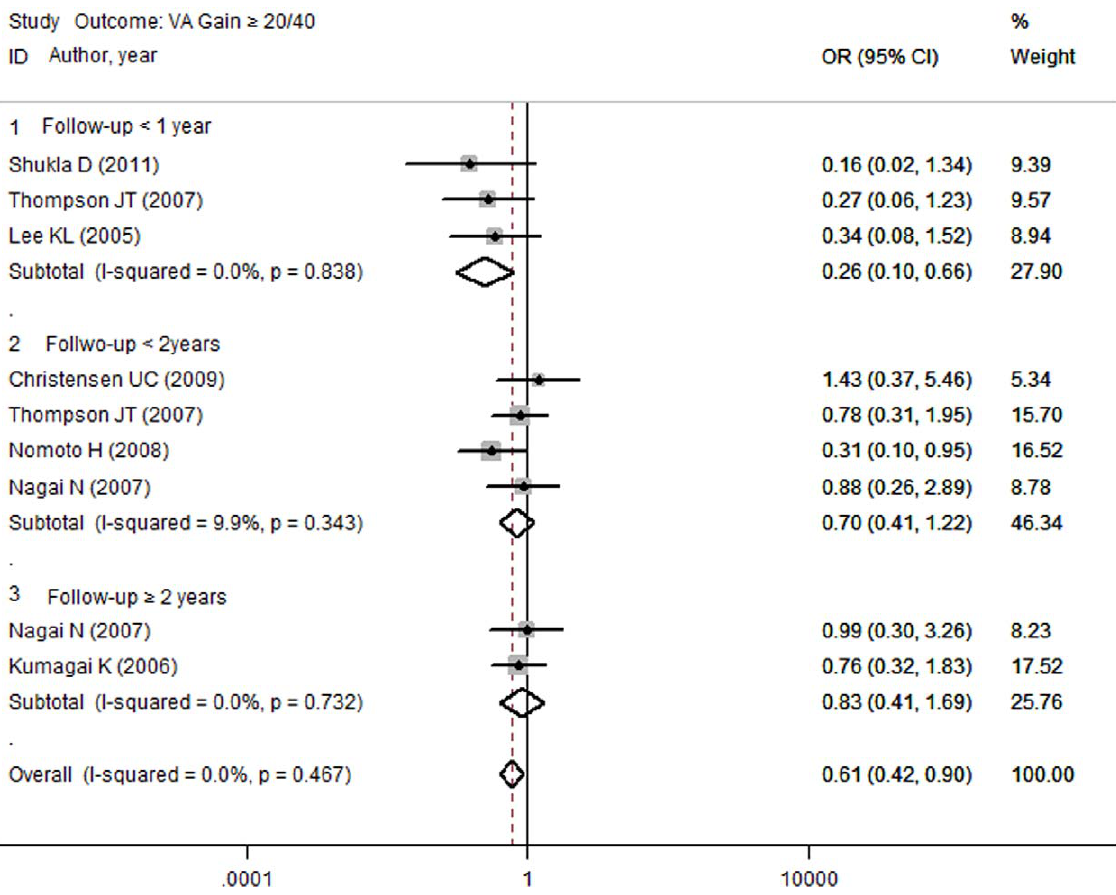
Outcome of Interest